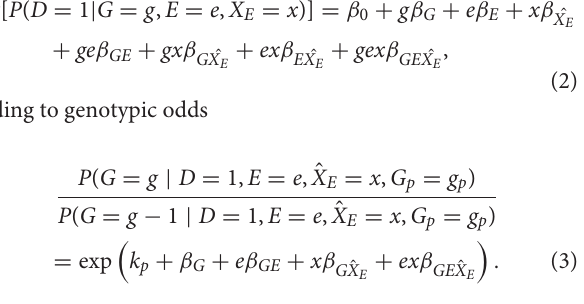
(2012) to explore whether the G × E interaction effects reported by Beaty et al. (2011) could be